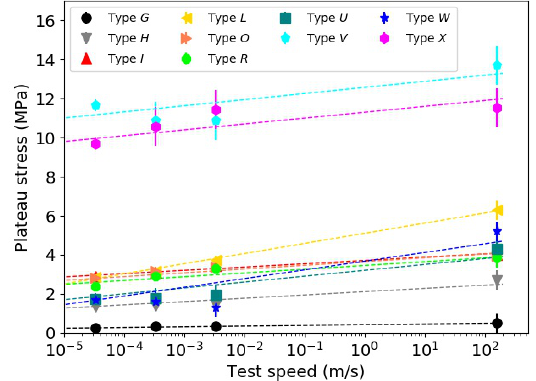
Figure 17. Plateau stress vs. test speed for the investigated